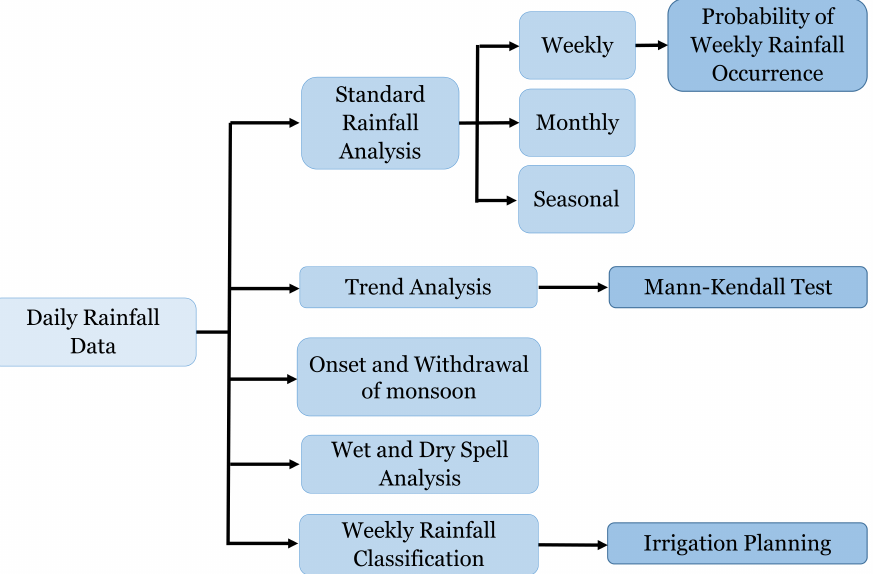
Figure 2. Schematic illustration of the rainfall analysis implemented in this